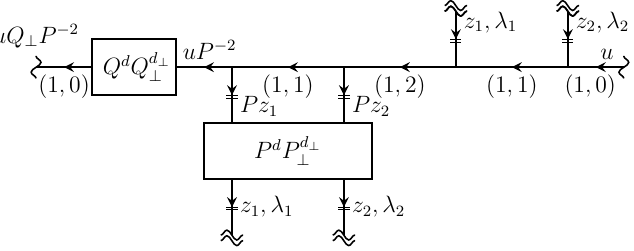
Figure 2 . Compacti(cid:12)ed network of intertwiners corresponding to the same 6 d U(2) gauge theory with adjoint hypermultiplet, as in (cid:12)gure 1. The grading operators Q d Q d ? states of the Fock representations in the same way as the Boltzman factor e (cid:0) (cid:12)H counts the states in a quantum mechanical partition